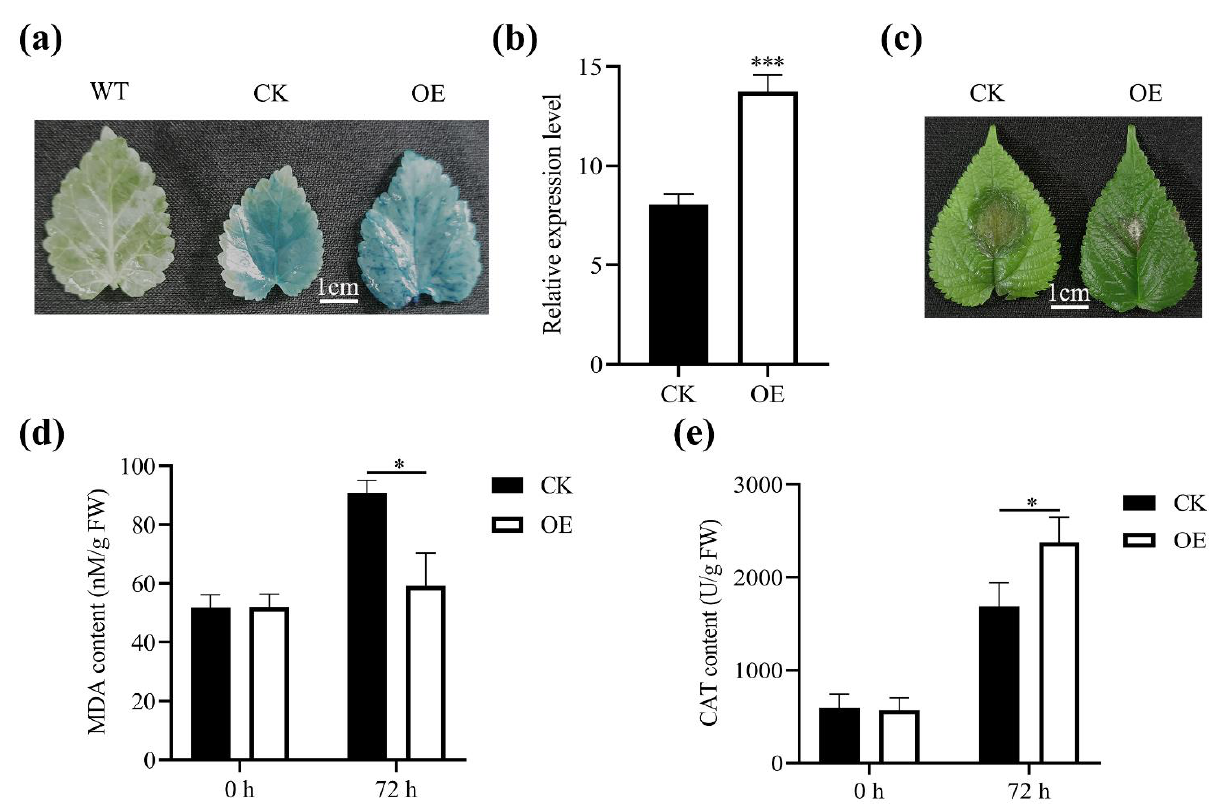
Figure 7. Analysis of MnASI1 resistance to B. cinerea using mulberry transient expression. ( a ) GUS staining of untreated and transiently expressed mulberry leaves. ( b ) Expression analysis of MnASI1 in transiently expressed mulberry leaves. ( c ) Mulberry leaves were photographed 72 h after infection with B. cinerea . ( d ) Malondialdehyde (MDA) content. ( e ) Catalase (CAT) activity. CK, empty vector transgenic; OE, MnASI1 transgenic. Error bars represent standard deviation, n = 3 (* p -value < 0.05 and *** p -value < 0.001; two-tailed t -test).